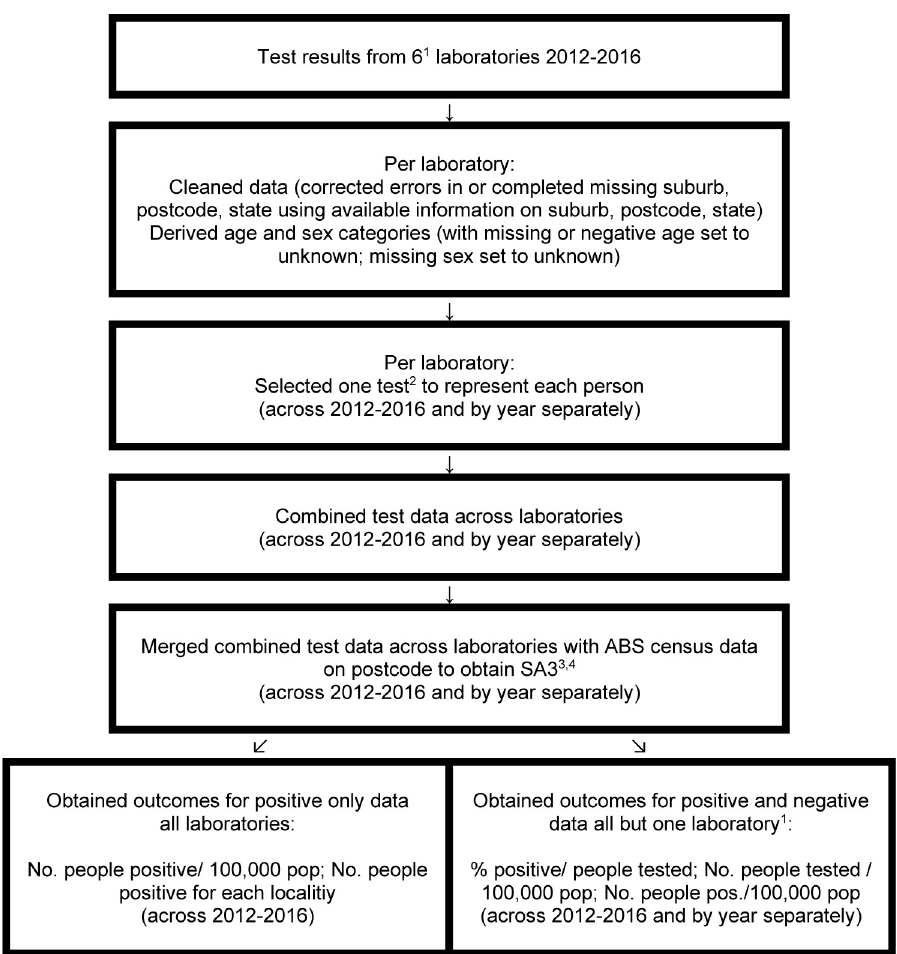
Fig 1. Flowchart: data processing steps of Strongyloides IgG ELISA serology test results. 1 Positive and negative results for 5 laboratories, positive only results for laboratory in South Australia. 2 For those who tested positive at least once, the selected test was the first positive test. For those who tested only equivocal or negative, the selected test was the first equivocal or negative test. 3 SA3 was based on 2011 ABS census data. When merging ABS data with the combined test data across 2012–2016, ABS data with population sizes for 2012–2016 for each age and sex combination was used. When merging ABS data with the combined test data by year, ABS data with population sizes for each year 2012–2016 across all ages and sex combinations was used. 4 The resulting merged combined data set excluded overseas, remote island (Christmas Island, Norfolk Island, Lord Howe Island, Keeling Island), and missing suburbs. For those postcodes that were linked to more than one SA3, the SA3 was selected manually using the person’s postcode, suburb and state information together with the ABS postcodes map and Google maps. ABS = Australian Bureau of Statistics; SA3 = Statistical Area Level 3 (region defined by ABS, 2011); pos = positive; pop =